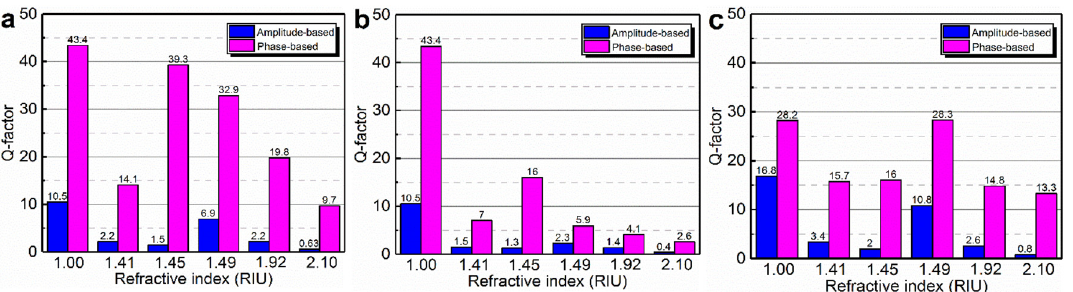
Figure8: ComparisonofQ-factorscalculatedbytheexperimentalamplitudespectraandphasespectra.(a)foroptimalgaps;(b)for g =40 μ m; (c) for g = 65 μ m.